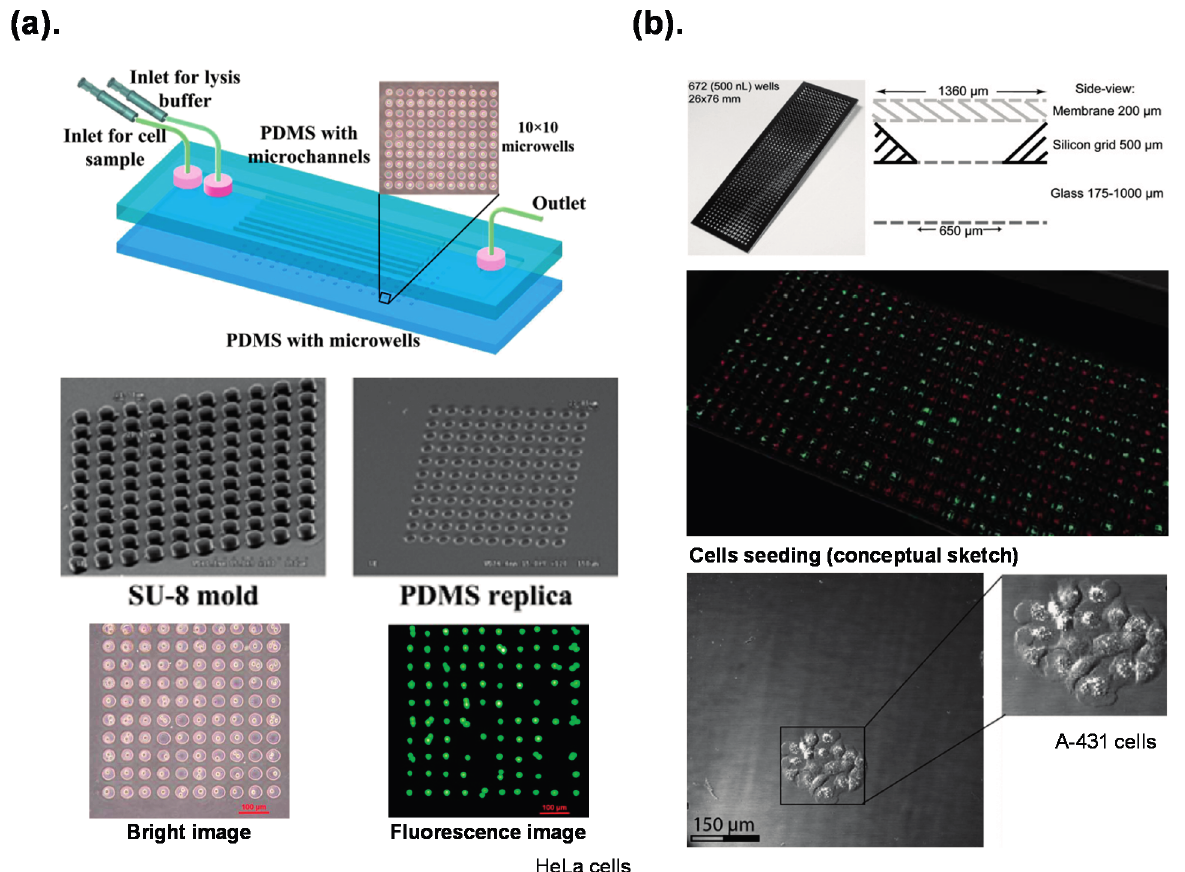
Figure 1. Individual cells isolated on a chip with microwells described in: ( a ) Jen et al. , 2012 [24]; ( b ) Lindstrom et al. , 2009 [21]. Reproduction of the figures has been made with permission from Multidisciplinary Digital Publishing Institute and The Royal Society of